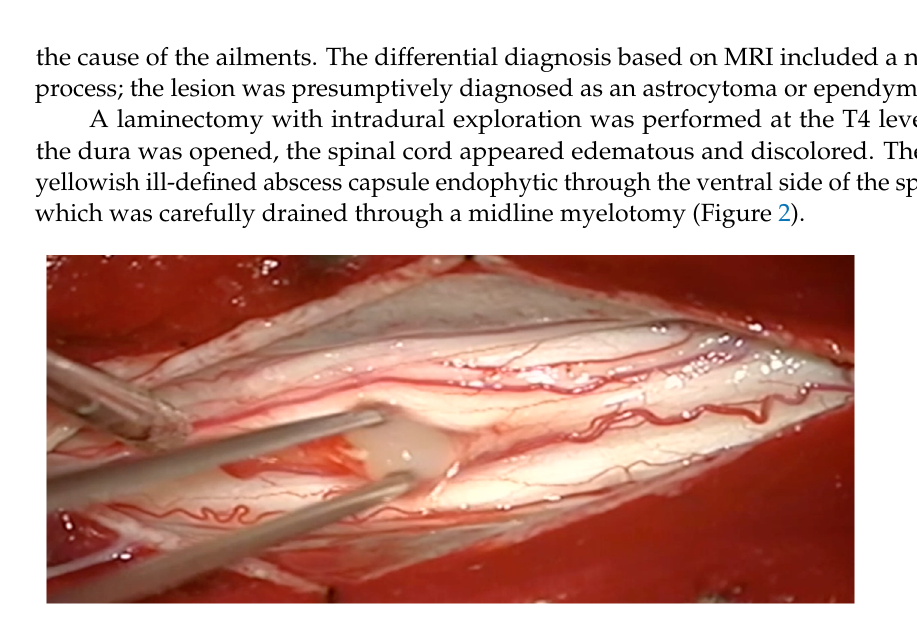
Figure 2. Intraoperative view of lesion showing yellowish pus after myelotomy at T4 level. The spinal cord became lax after the abscess was drained. We encountered purulent fluid through the midline myelotomy from T3 to T4. The cavity was irrigated with saline, the dura was stitched, and the wound was closed in layers, with drainage